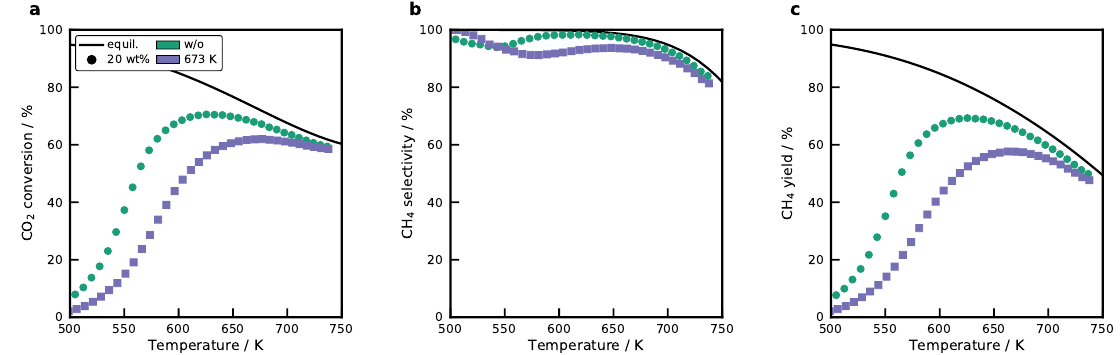
Figure 11. ( a ) CO 2 conversion, ( b ) CH 4 selectivity, and ( c ) CH 4 yield for the Ni/ γ -Al 2 O 3 catalysts. Only the two catalysts were tested, which have a sufficient DOR . Conditions: m cat = 30mg, β = 20Kmin − 1 , WHSV = 100L N h − 1 g − 1